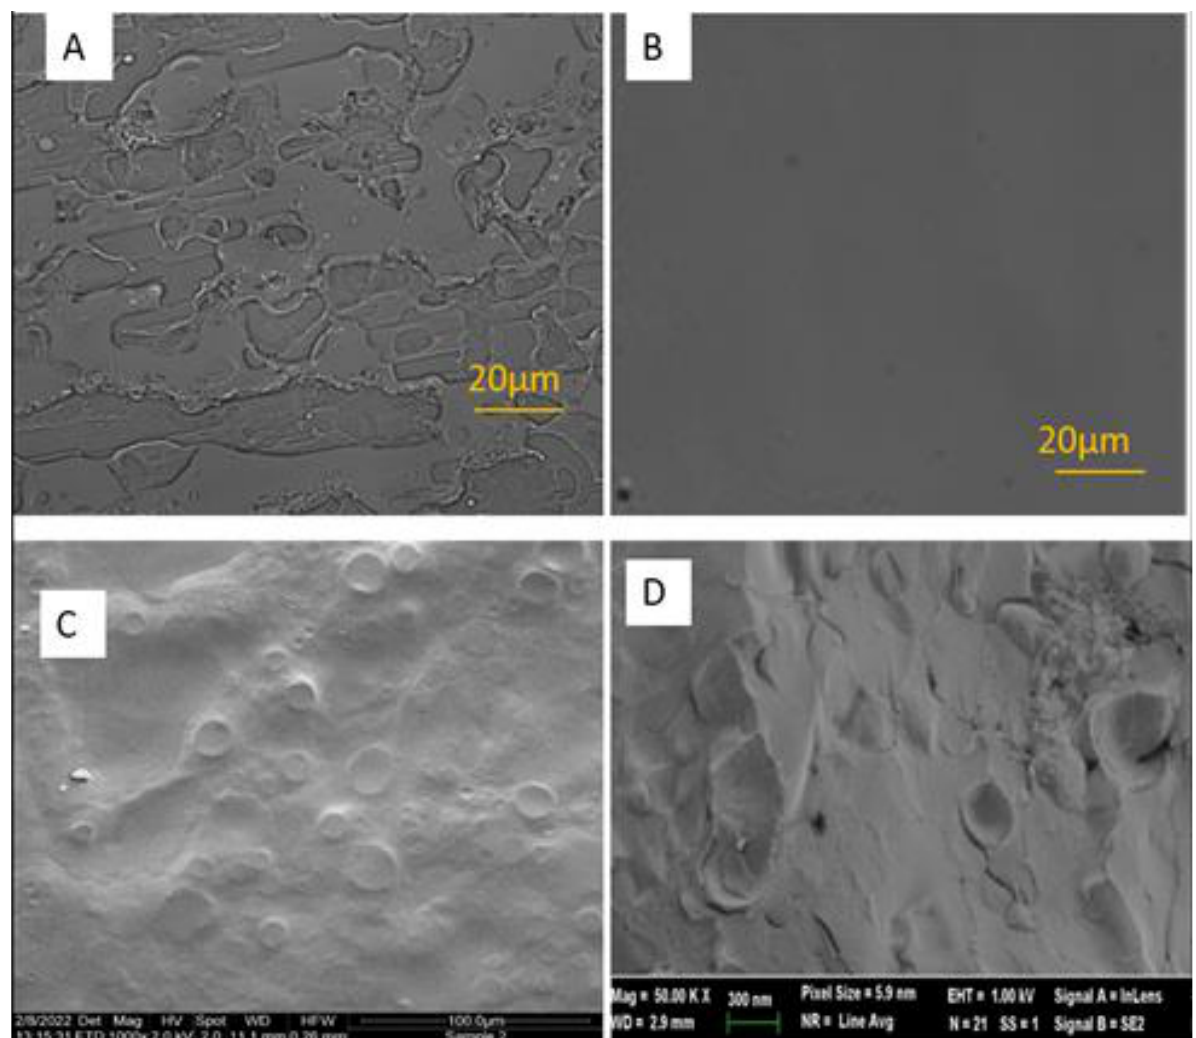
Figure 1. Structured Weblike film obtained from: ( A ) Weblike carrier (F9) by light microscopy using ×40 objective lens; ( B ) Control system not containing phospholipid by light microscopy), using ×40 objective lens; ( C ) Weblike carrier (F4) by SEM ×500; ( D ) Weblike carrier (F2) by CryoSEM. For the carriers ’ compositions, see Table 1.